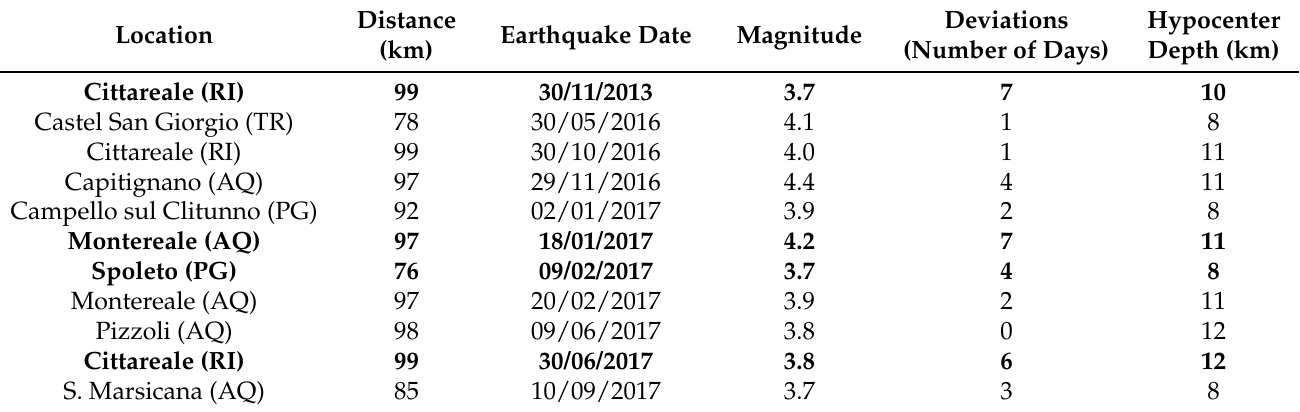
Table 4. Seismic events related to environmental gamma anomalies detected at the Casaccia Research Center site. Those events where anomalies persisted for the longest time period (in days) are reported in bold font. The distance from the detector was calculated using the Haversine formula.